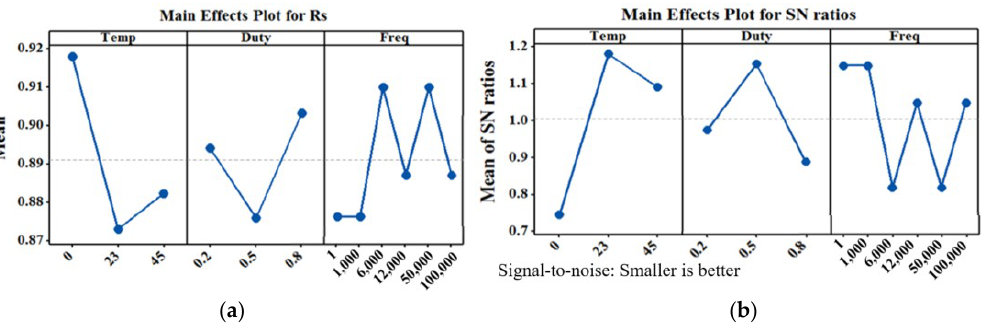
Figure 10. ( a ) Main effects plots for R s ; ( b ) Main effects plots of SN for R s .